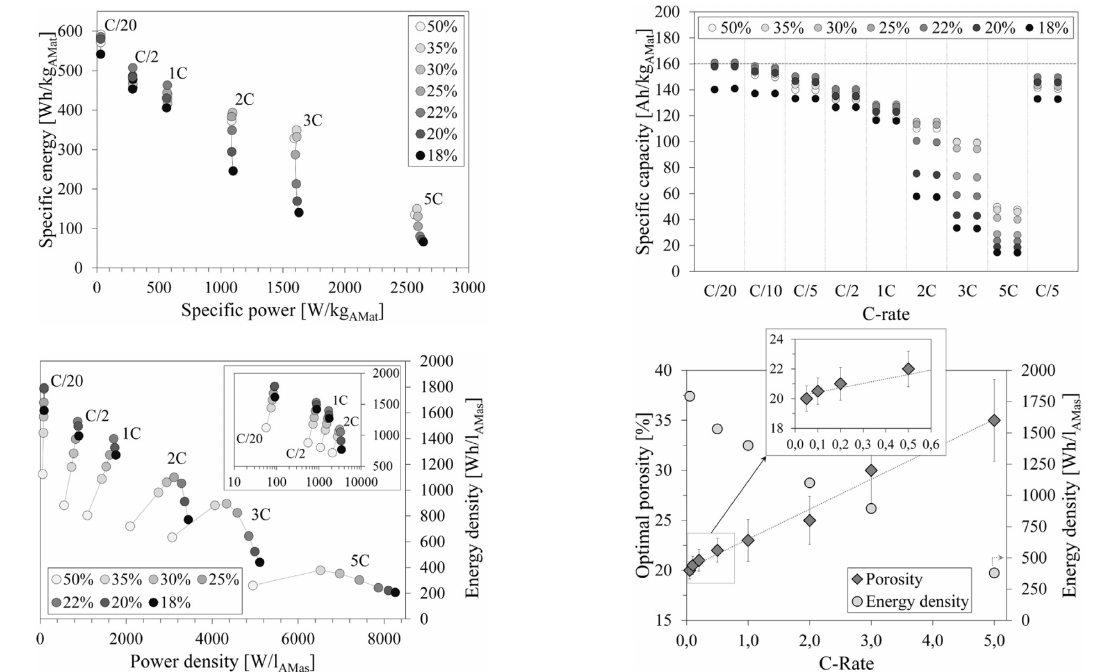
Figure 16. ( Top ) Porosity effect on NMC (LiNi 0.33 Co 0.33 Mn 0.33 O 2 ) cathodes: (left) specific energy vs. specific power and (right) specific capacity vs. C-rate; ( Bottom ) Ragone plots between C/20 and 5C: (left) energy density vs. power density (volumetric evaluation) and (right) optimal porosity to achieve the maximum energy density. Reproduced with permission [70].